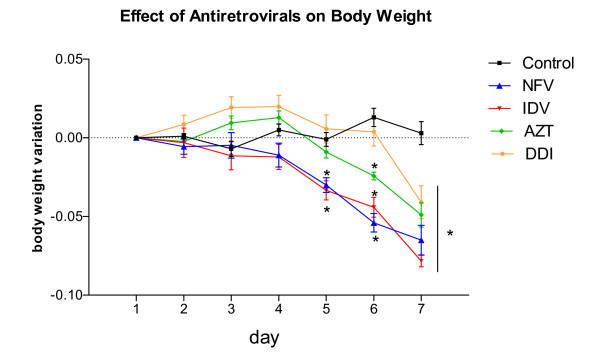
Effect of NFV (100 mg/kg), IDV (100 mg/kg), AZT (50 mg/kg) and DDI (100 mg/kg) on body weight in mice. Each animal was weighed daily throughout the experiment. The results are expressed as mean ± SEM of at least six mice per group. *statistical significance (P < 0.05) compared to the PBS control group by ANOVA, Bonferroni's multiple test.